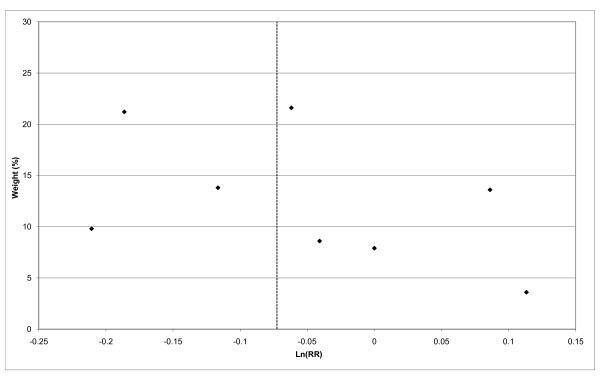
Funnel plot for risk of lung cancer by use of mentholated cigarettes. Funnel plot of the eight relative risk estimates for use of mentholated cigarettes and lung cancer shown in Figure 2 against their weight (inverse-variance of log RR.) The dotted vertical line indicates the fixed-effect meta-analysis estimate.